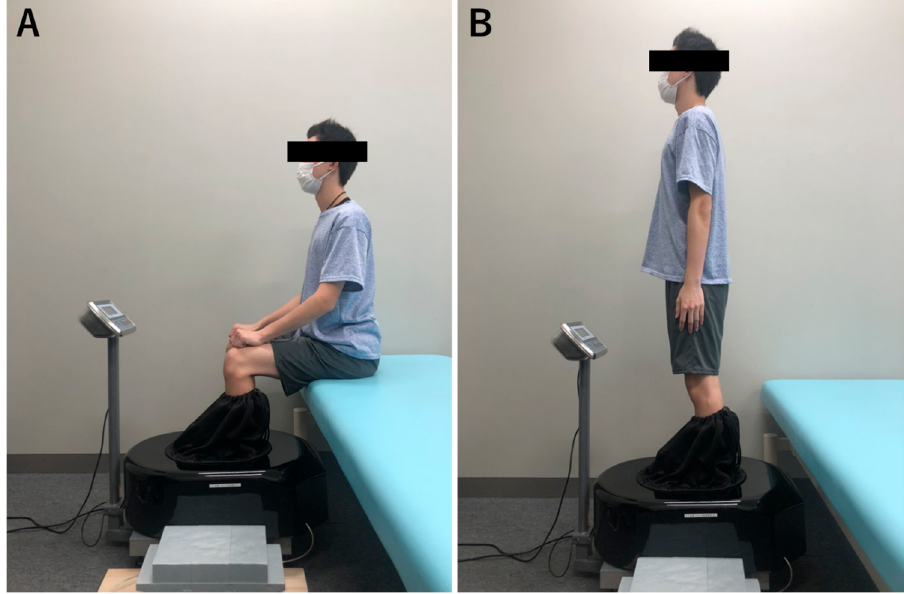
Figure 3. Methods of measuring foot characteristics. ( A ) Ten percent load condition. ( B ) Fifty percent load condition.